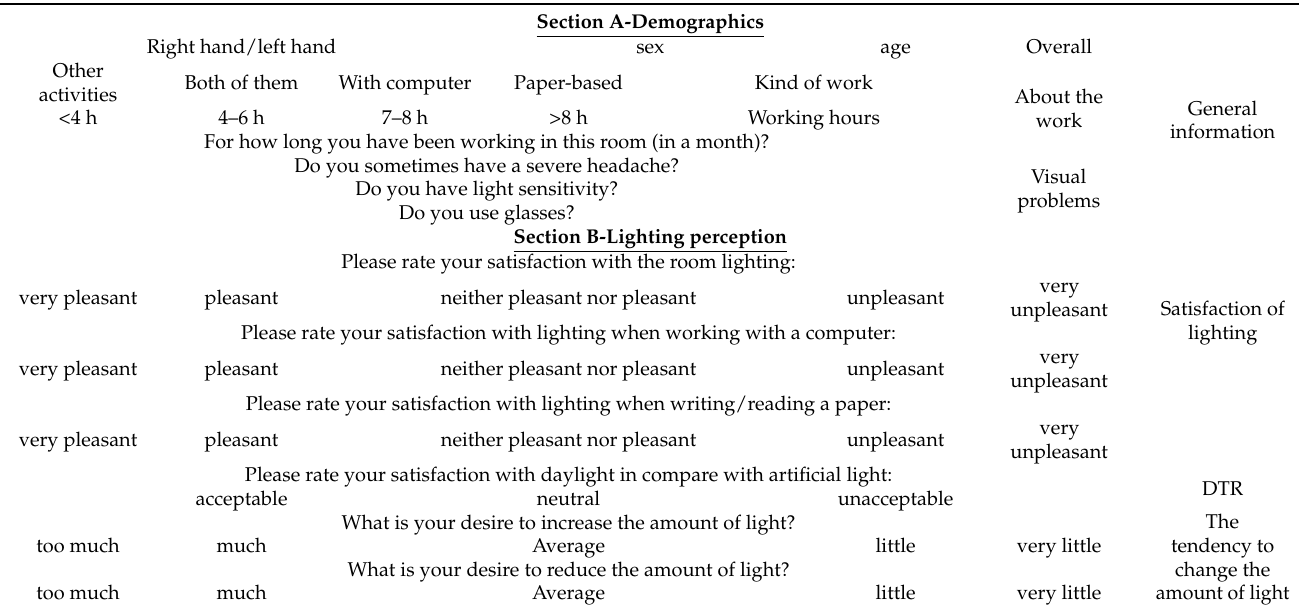
Table A1. Summary of the survey